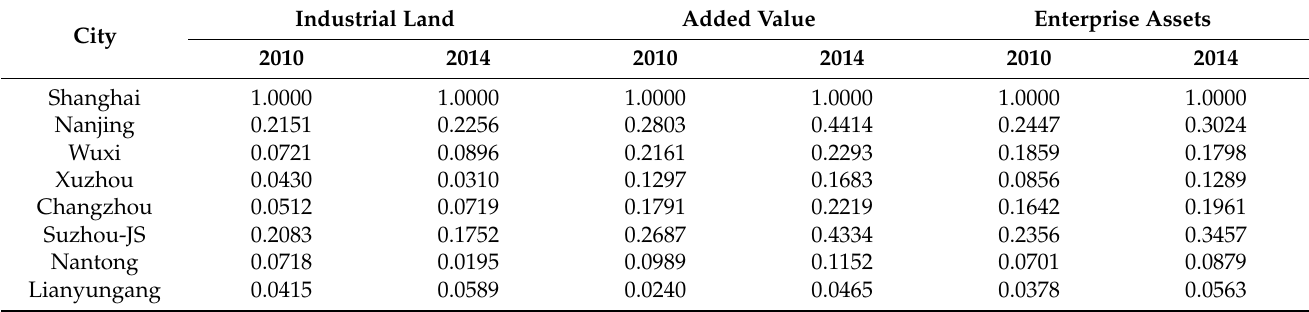
Table A3. Index data based on the max-min standardization method in 2010 and